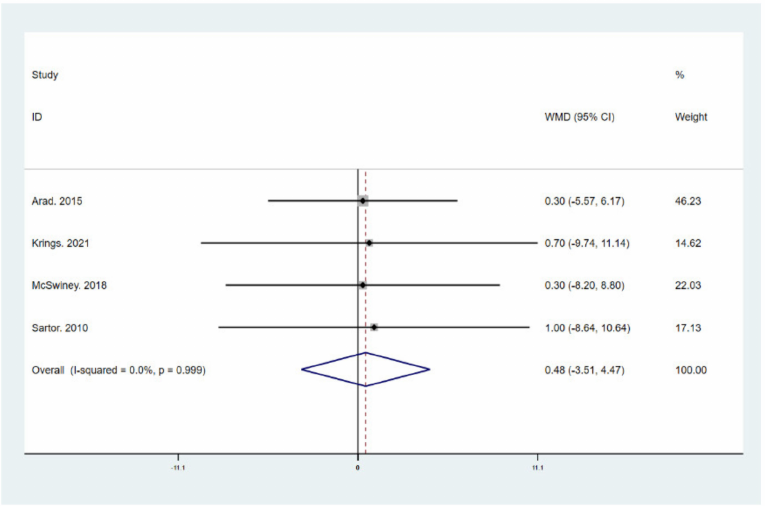
Figure 9. Forest plot for the effect of a low-carbohydrate high-fat (LCHF) diet combined with HIIT on fat free mass (FFM). For each study, squares represent the mean difference in intervention effects, with horizontal lines intersecting them as the lower and upper limits of the 95% CI. The size of each square represents the relative weight of the studies conducted in the meta-analysis. The diamond represents the results of the meta-analysis combining the individual